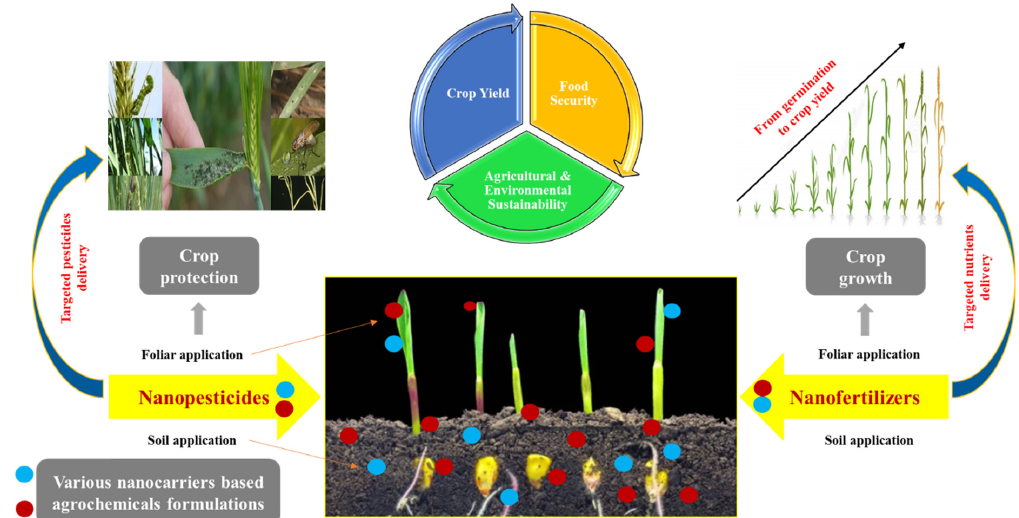
Figure 2. A schematic diagram illustrating the application of nanopesticides and fertilizers in modern agriculture. The targeted delivery of these nano-agrochemicals via foliar and/or soil application provides protection to crops from various pests and enhances utilization and uptake efficiency of nutrients for ameliorating crop growth and yield in order to achieve food security, agricultural, and environmental